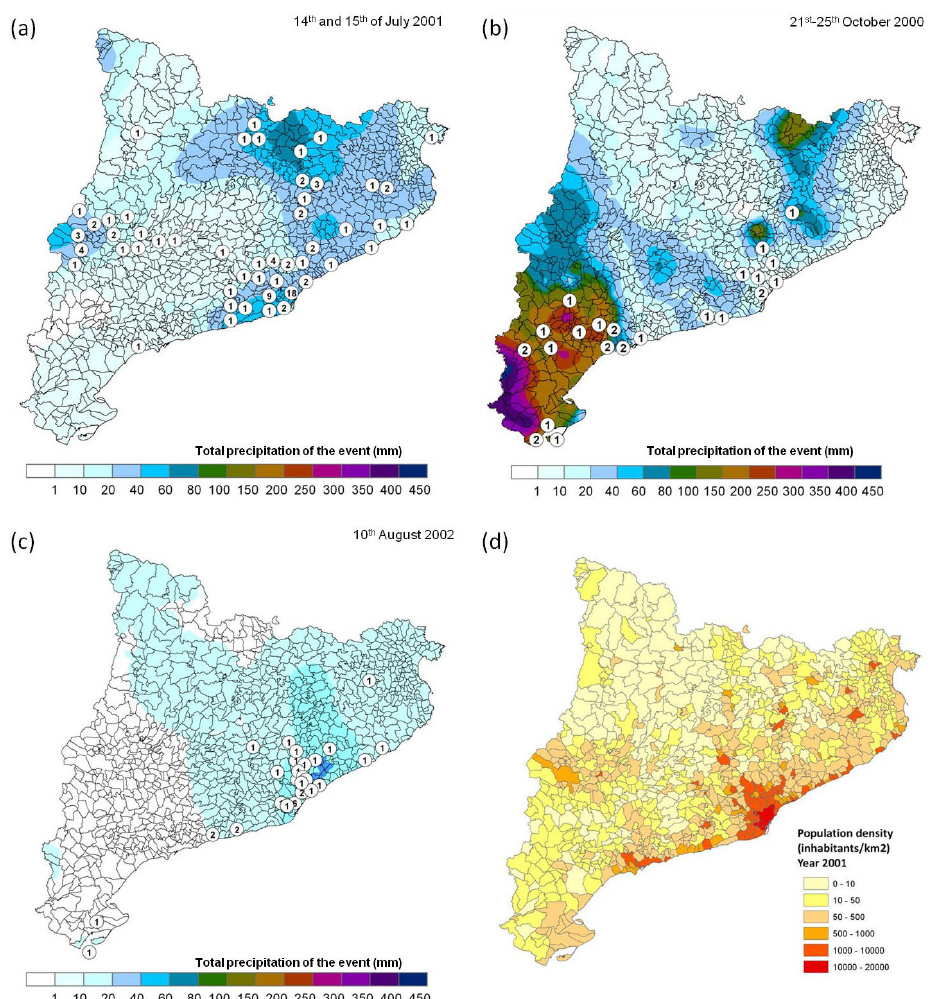
Figure 3. Total precipitation and number of requests received from each municipality in the 6 months following the events of (a) 14– 15 July 2001, (b) 21–25 October 2000 and (c) 10 August 2002. Distribution of accumulated rainfall is represented with colours and the number of requests received by municipality is indicated in circles. The map of population density by municipality in Catalonia in the year 2001 is shown in (d) ; data obtained from the Instituto Nacional de Estadística